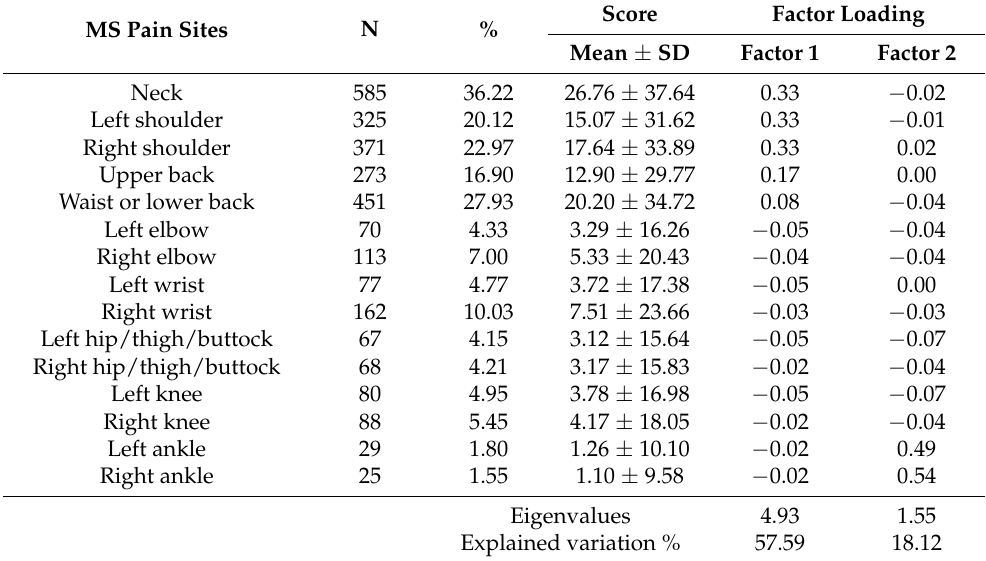
Table 1. MS pain sites and factor analysis of the